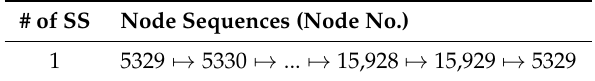
Table 6. Static Schedule (SS) for initial marking vector [ p 0 p 1 p 2 p 3 p 4 p 5 ] = [0 5760 0 5292 0 5292] under a single-server semantics for MP3 playback